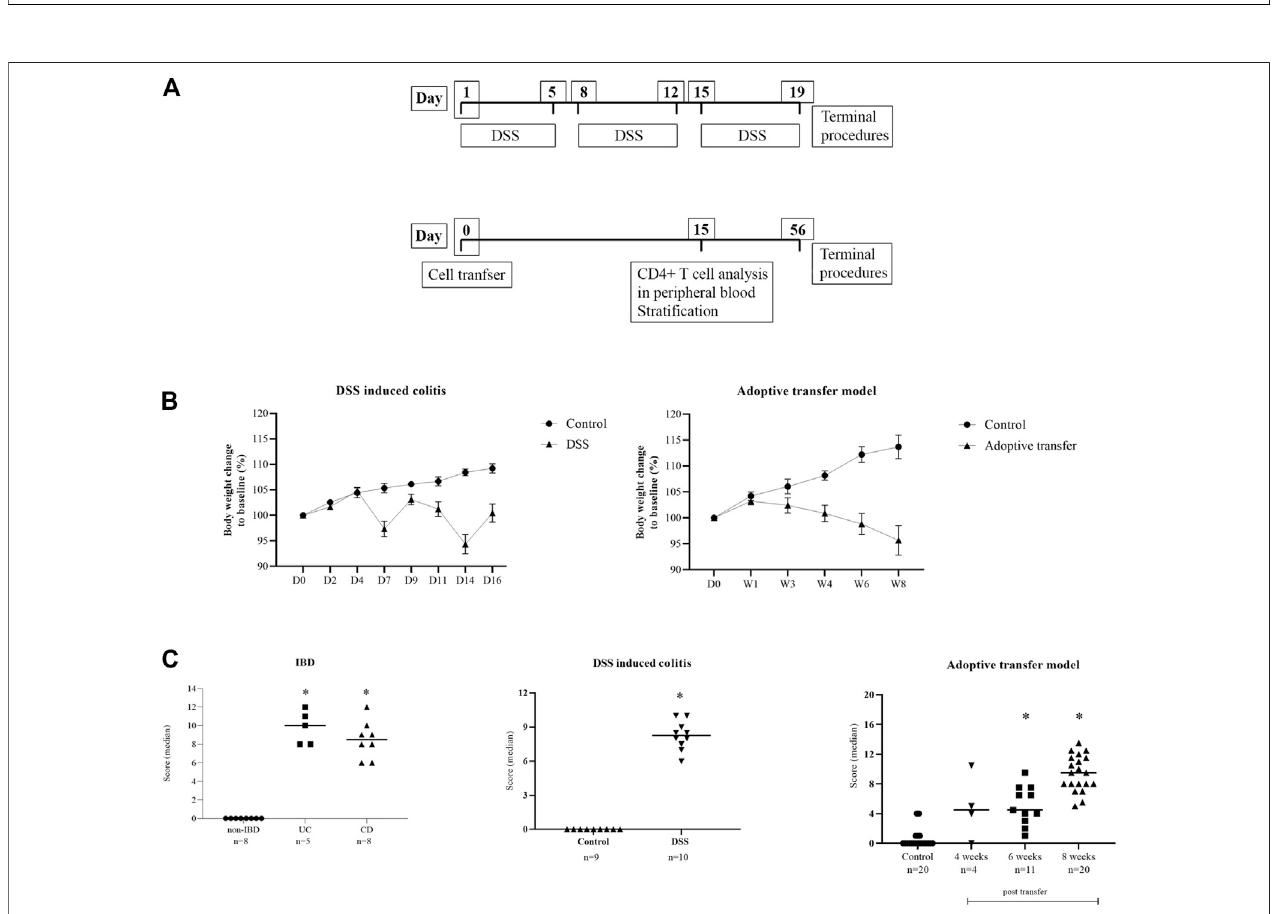
FIGURE 3 | (A) Diagrams of the experimental protocols for the induction of DSS colitis and adoptive transfer model in mice. (B) Body weight change in animal models. Dataare presented asmean ± SEM(D, day;W,week). (C) Disease activity score. Scoreisgiven asgroup median; Mann – Whitneynonparametric test; p < 0.05 vs. control; IBD (Naini and Cortina, 2012), DSS (Nishitani et al., 2009), adoptive transfer model (Laroux et al., 2004).